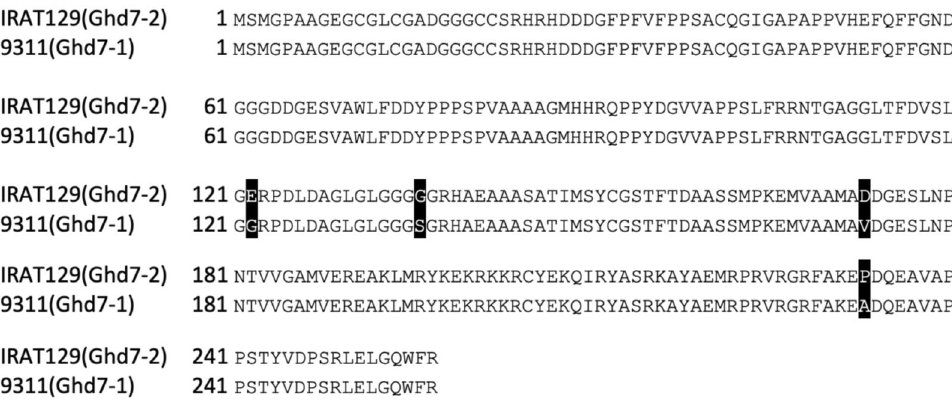
Figure 2. The predicted protein sequences of GHD7 for IRAT129, 9311, H611 and